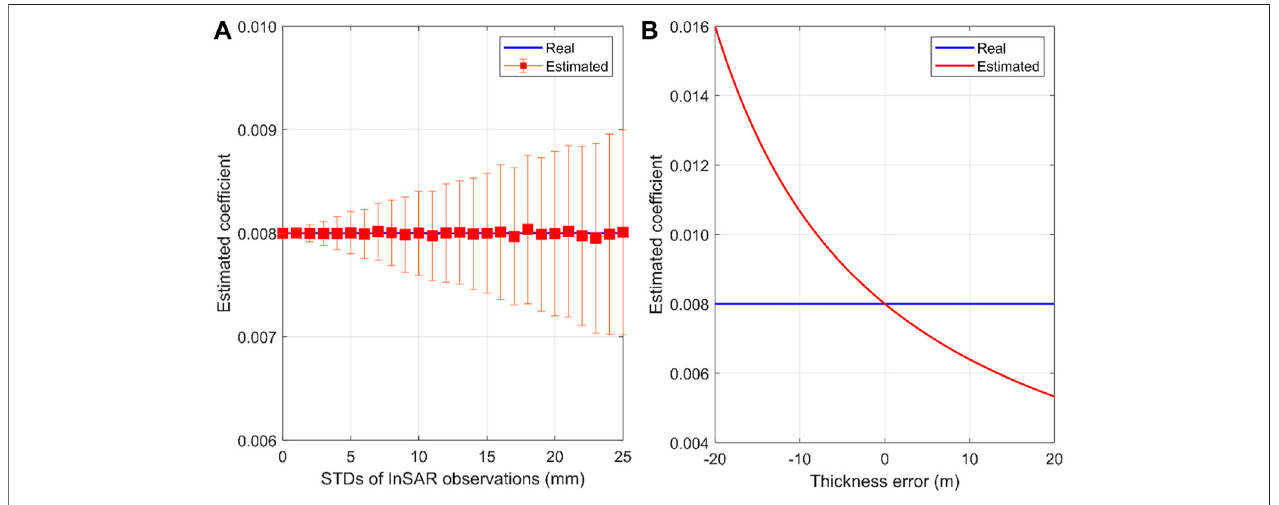
FIGURE 9 | In fl uences of InSAR observation errors (A) and dump thickness errors on the estimated coef fi cients of secondary consolidation (B) .